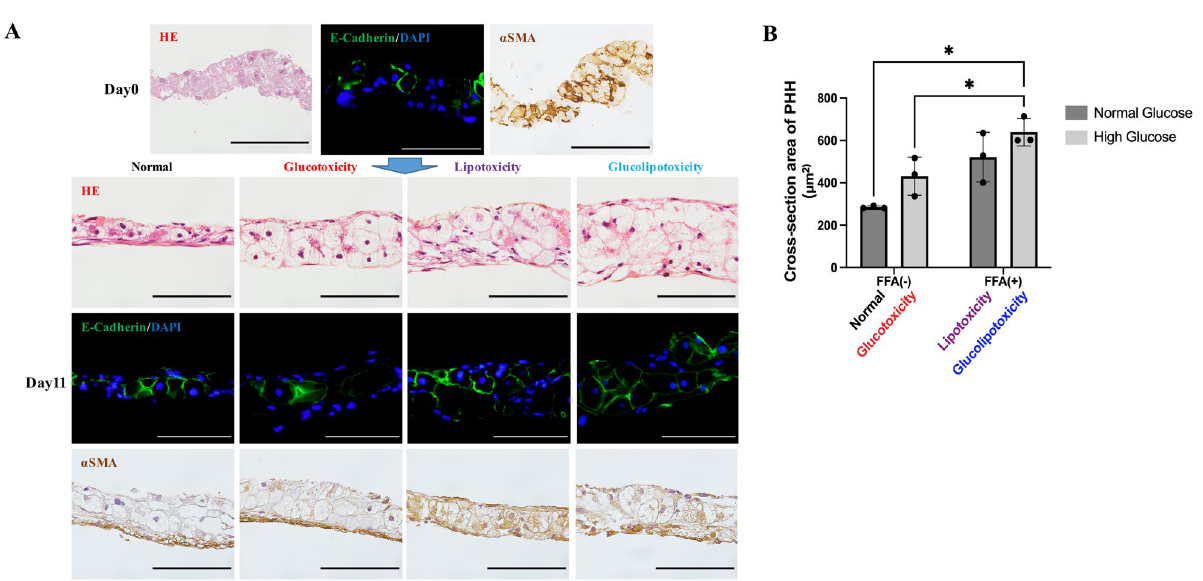
Figure 3. Histological analysis. ( A ) Representative images of HE staining and immunohistochemistry staining. Green: E-Cadherin, Blue: DAPI. Scale bar, 100 μm. HE: Hematoxylin–eosin, αSMA: Alpha-smooth muscle actin. ( B ) Evaluation of PHH ballooning. Ballooning was largest in the glucolipotoxicity group, n = 3, * p < 0.05. PHH: Primary human